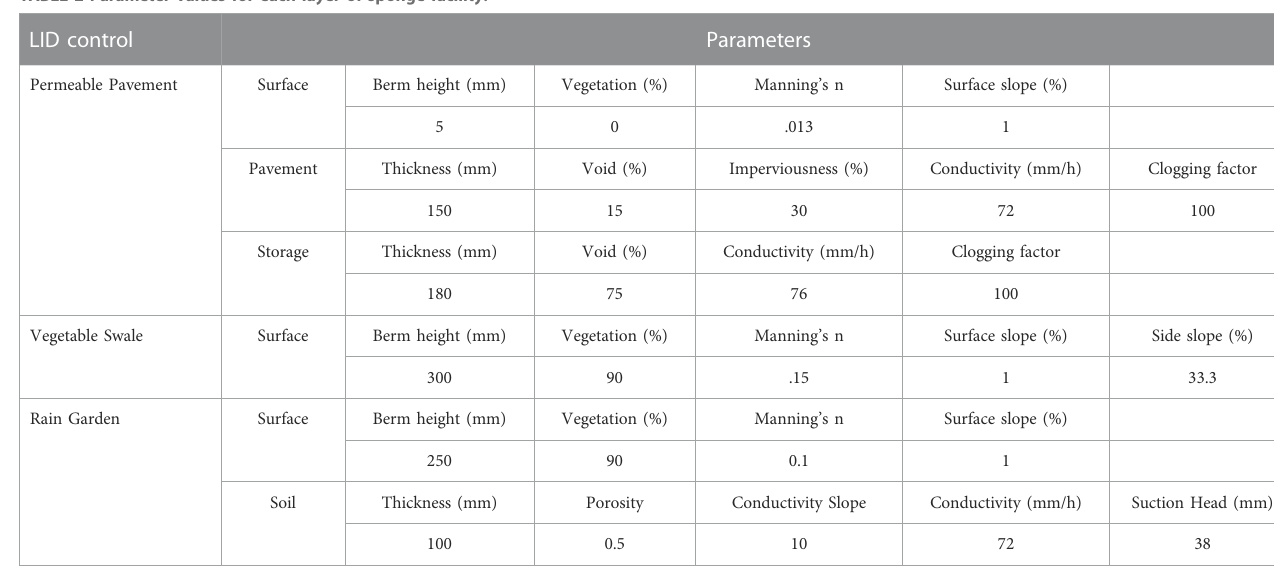
TABLE 2 Parameter values for each layer of sponge